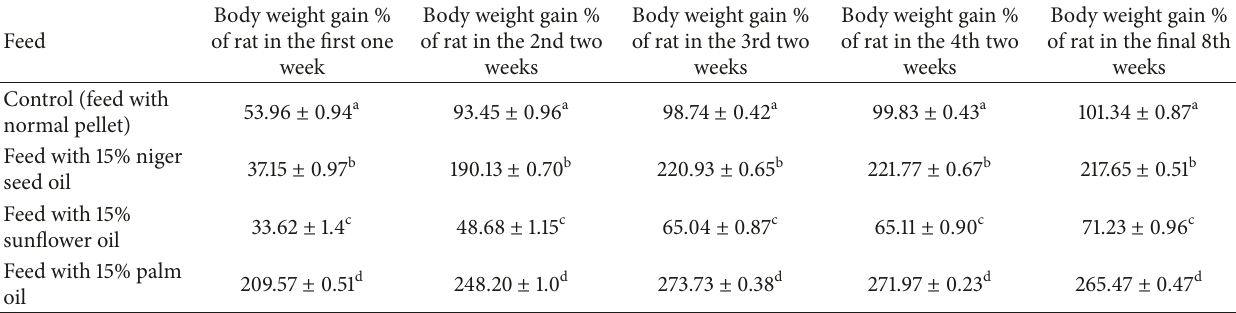
Table 2: The characteristic mean level of the body weight gain percentage (BWG %) of experimental animals (Wistar albino rats) through different weeks of the experimental period.